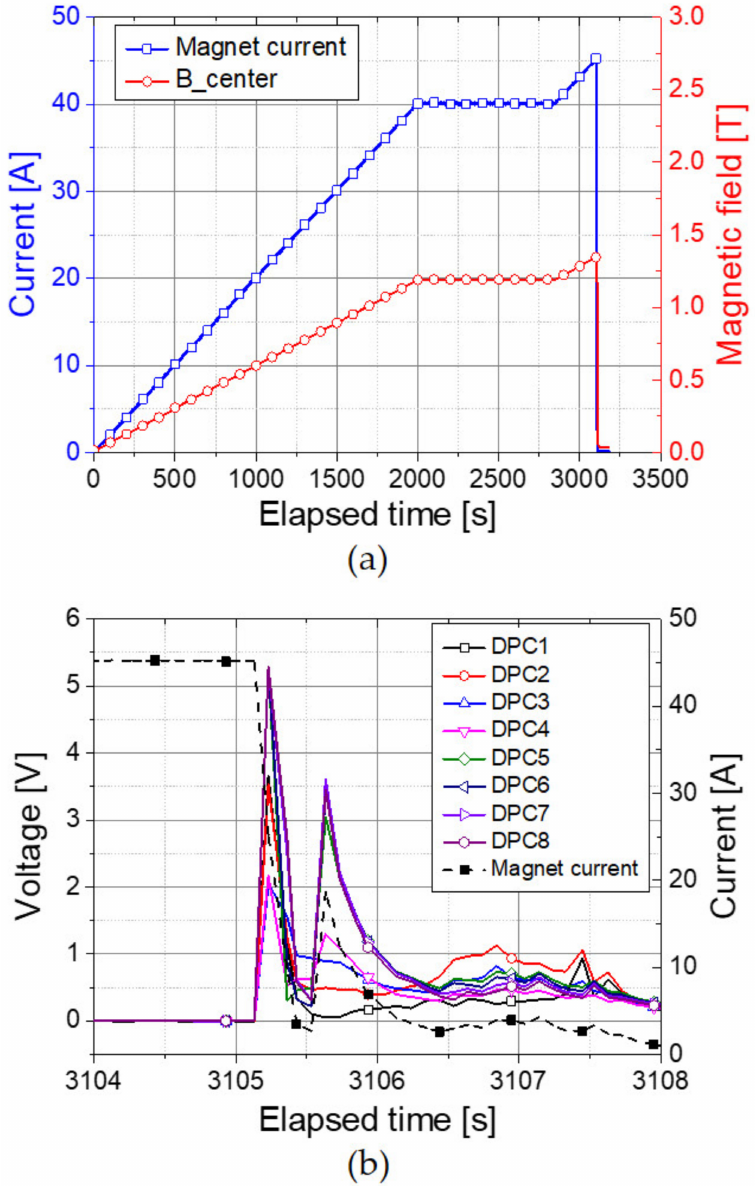
Figure 10. ( a ) Center magnetic field and current, and ( b ) voltages and current of eight DPC during the sudden discharge of the 3 T